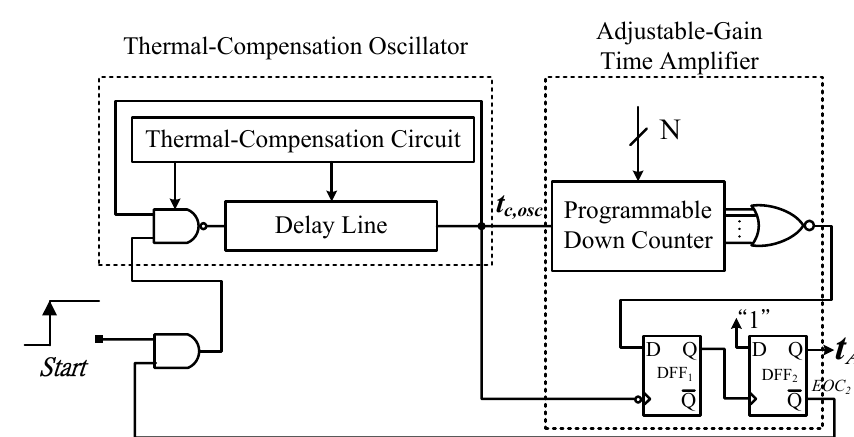
Figure 5. Block diagram of the ARDC.